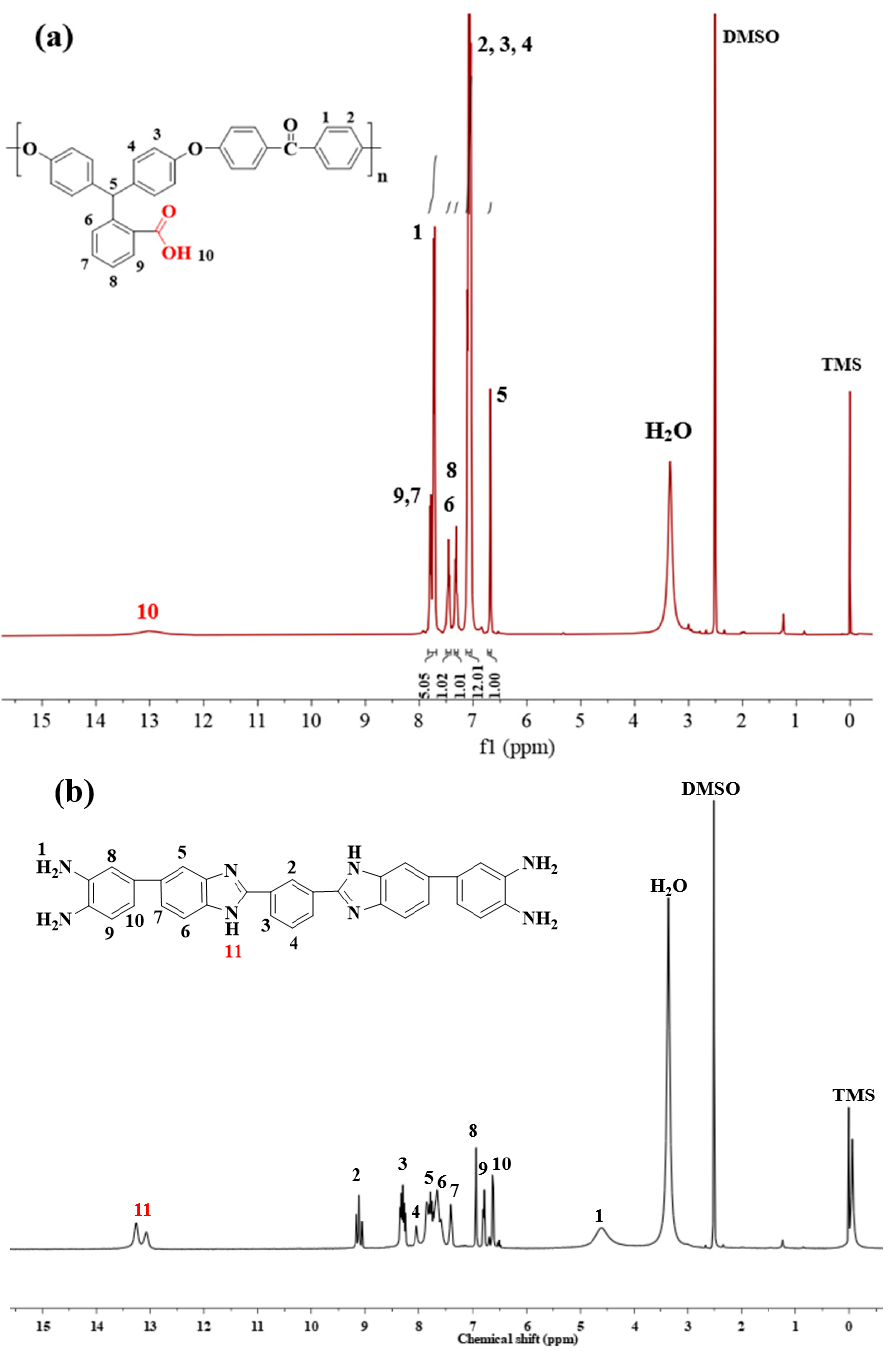
Figure 1. 1 H NMR spectra of ( a ) PAEK-COOH, and ( b ) PBI-4NH 2 in DMSO-d 6 .